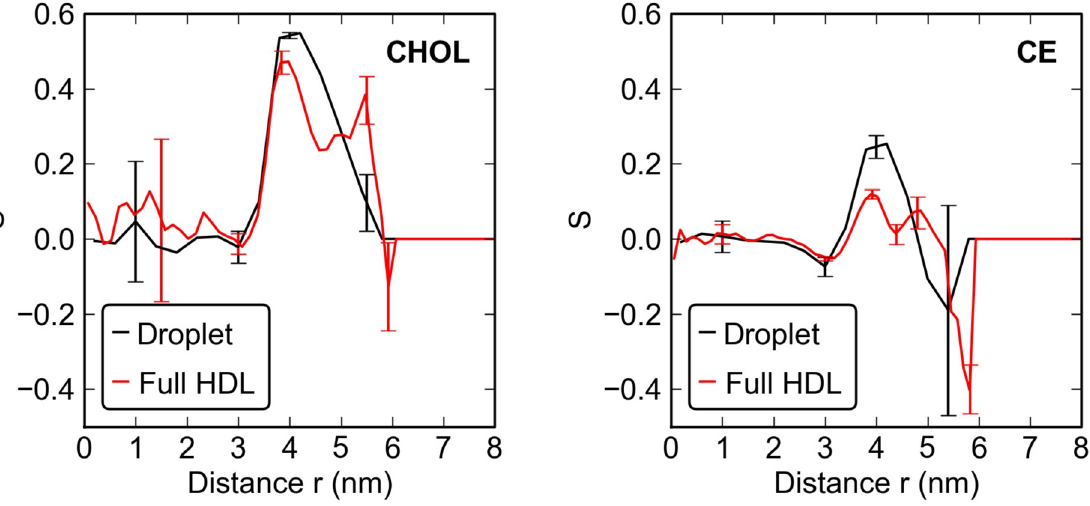
Figure 4. Order parameter S for the ring structures of CHOL (left) and CE (right). The black curves describe the lipid droplet and the red curves the full